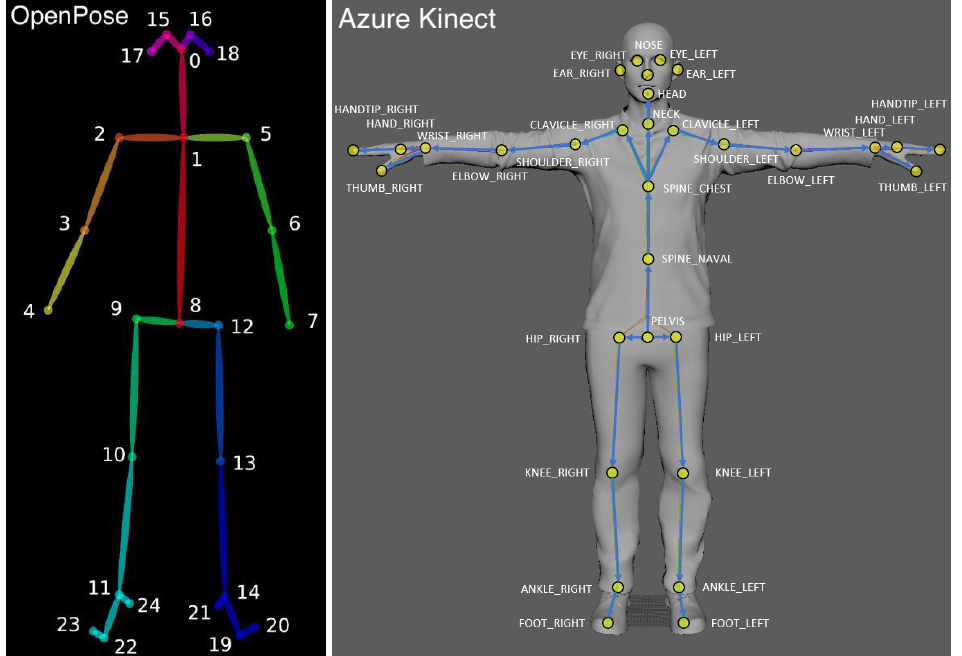
Figure 1. OpenPose ( Left ) and Azure Kinect ( Right ) skeletal joints